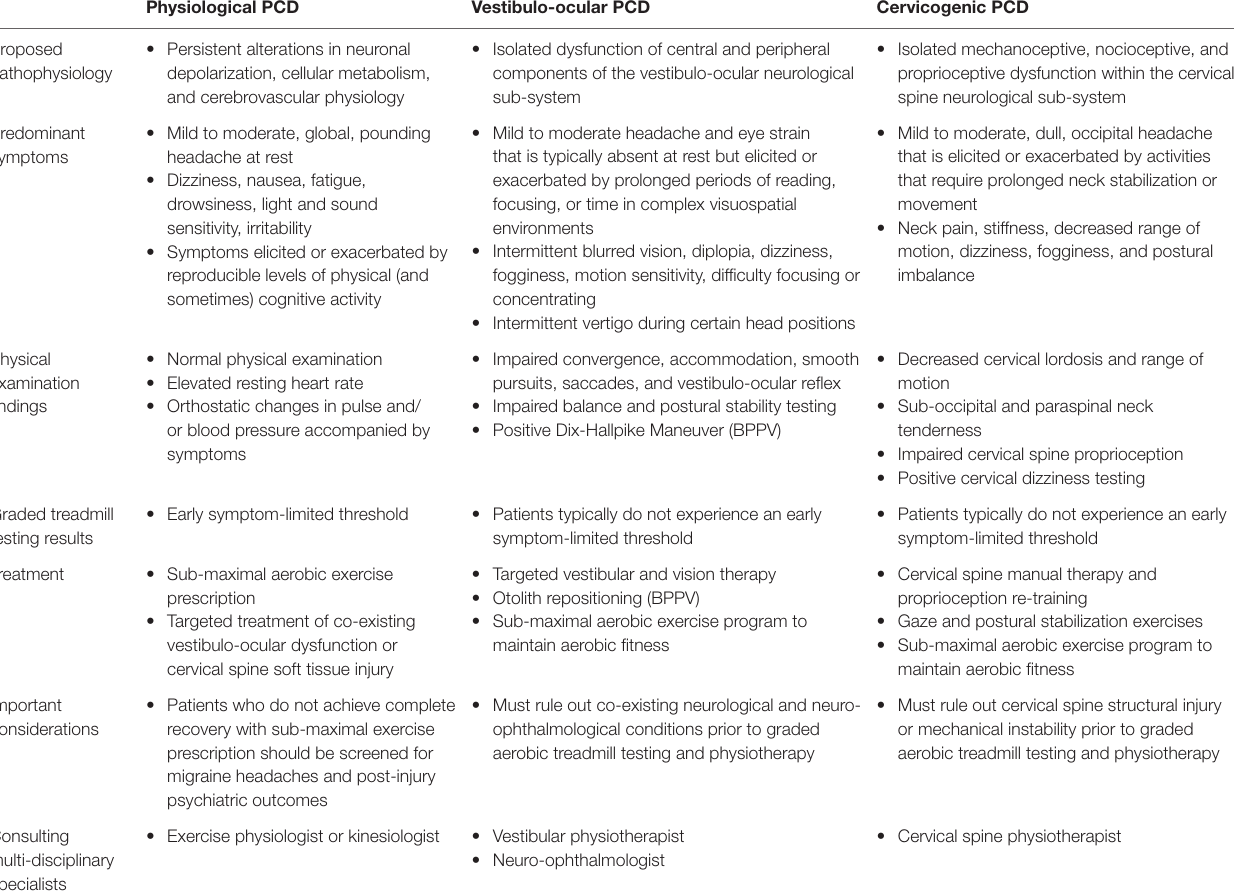
taBLe 1 | summary of proposed pathophysiology, predominant symptoms, physical examination findings, graded treadmill testing results, treatment recommendations, important considerations and multi-disciplinary consultations for post-concussion disorders. physiological